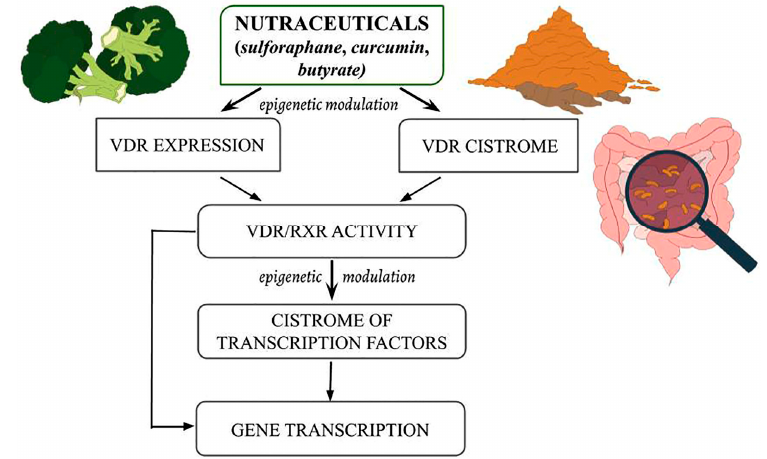
Figure 1. Schematic presentation of the possible effects of nutraceuticals on the epigenetic modulation exerted at three levels: vitamin D receptor (VDR) expression, VDR cistrome landscape, and chromatin remodeling triggered by vitamin D-VDR activity.